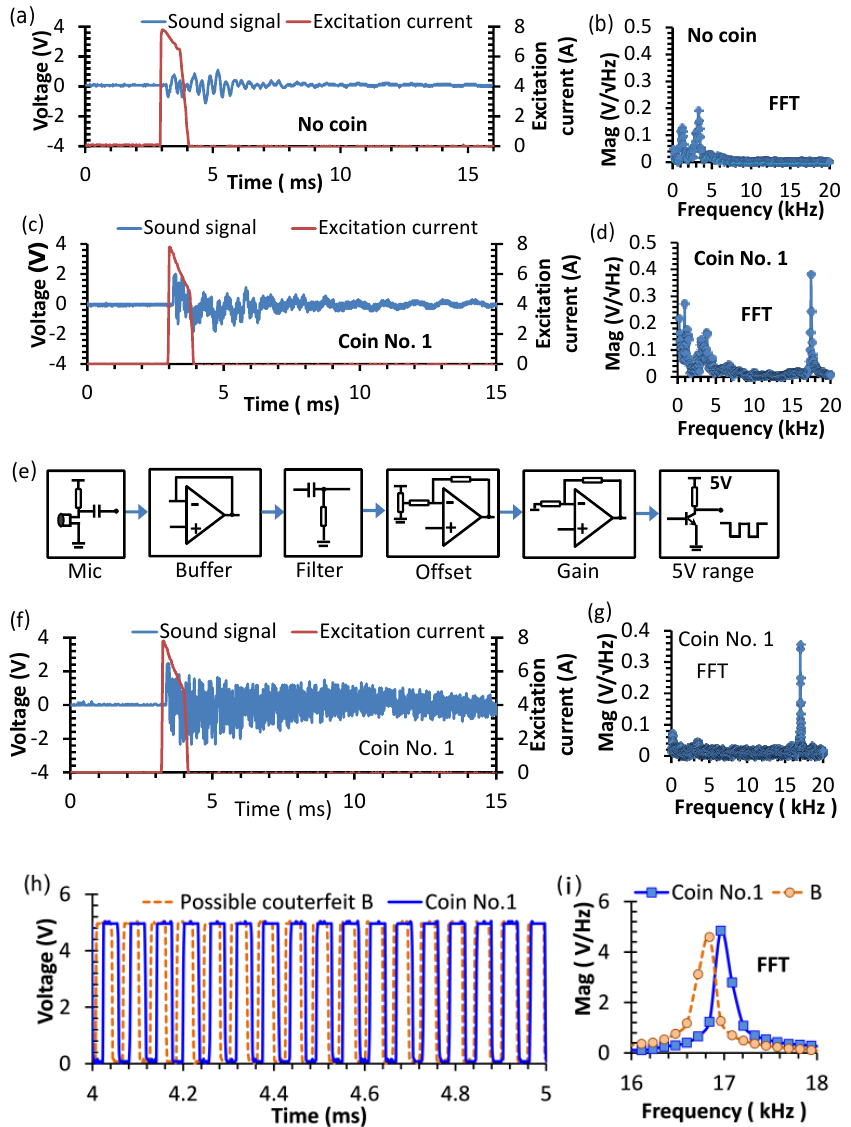
Figure 8. The original and transformed EMAT singals induced by a pulse current excitation: ( a ) the time-domain sound signal without a coin; ( b ) FFT spectrum of the signal without a coin; ( c ) the sound signal of the coin No.1 before filtering; ( d ) the FFT spectrum of the signal before filtering; ( e ) the functional diagram for the circuit transforming the sound signal to the square waveform; ( f ) the sound signal of the coin No.1 after filtering; ( g ) the FFT spectrum of the signal after filtering; ( h ) the sound signals of the coin No.1 and possible counterfeit coin B after passing the transforming circuit; and ( i ) the FFT spectrum of the signals after the transforming circuit.